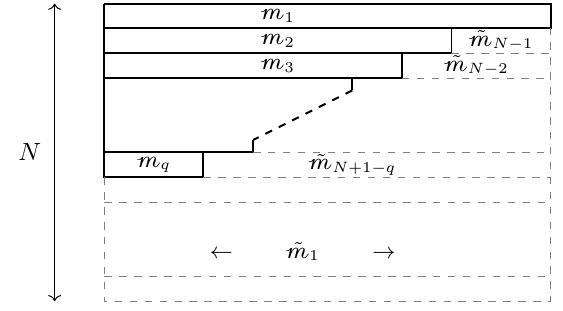
Figure 1 . A Young diagram m (black) and its dual ~ m